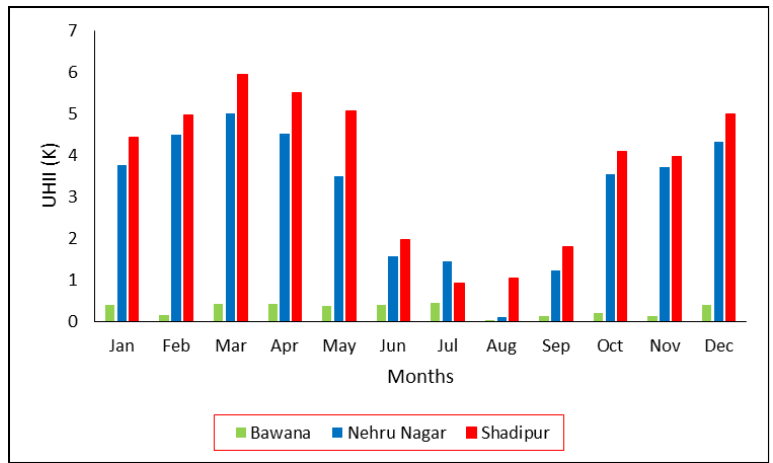
Figure 3. Monthly variation of surface heat island intensity over Delhi for the period of January 2018 – December